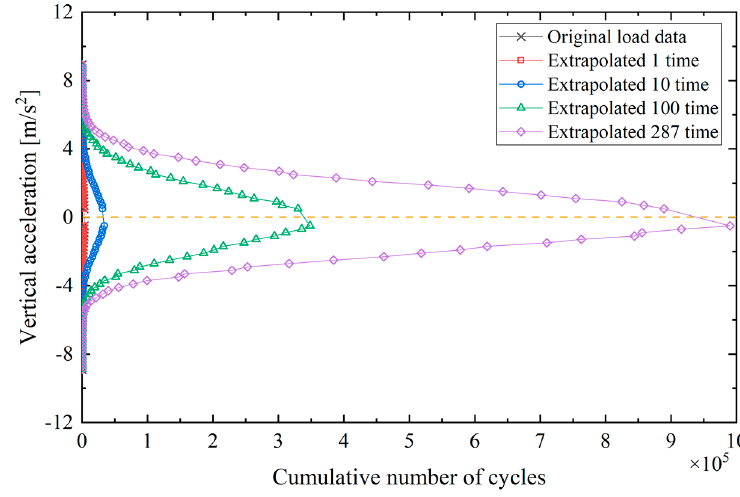
Figure 15. Loading cycle frequency curve of different extrapolation factors.